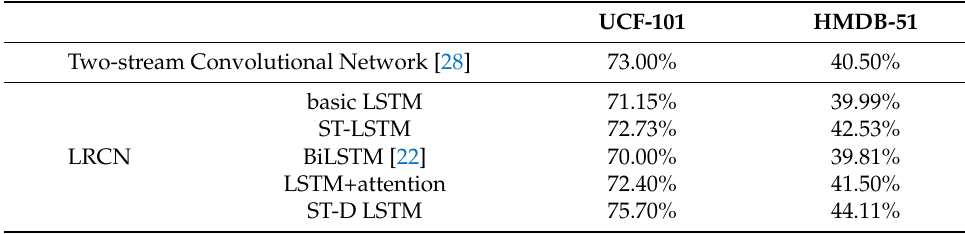
Table 4. The accuracy comparison of various deep learning algorithms on UCF-101 and HMDB- 51